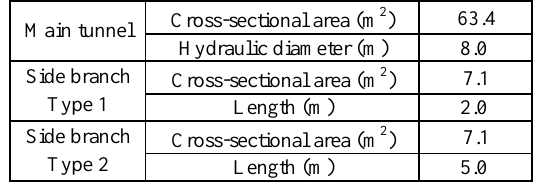
Table 2 Parameters for